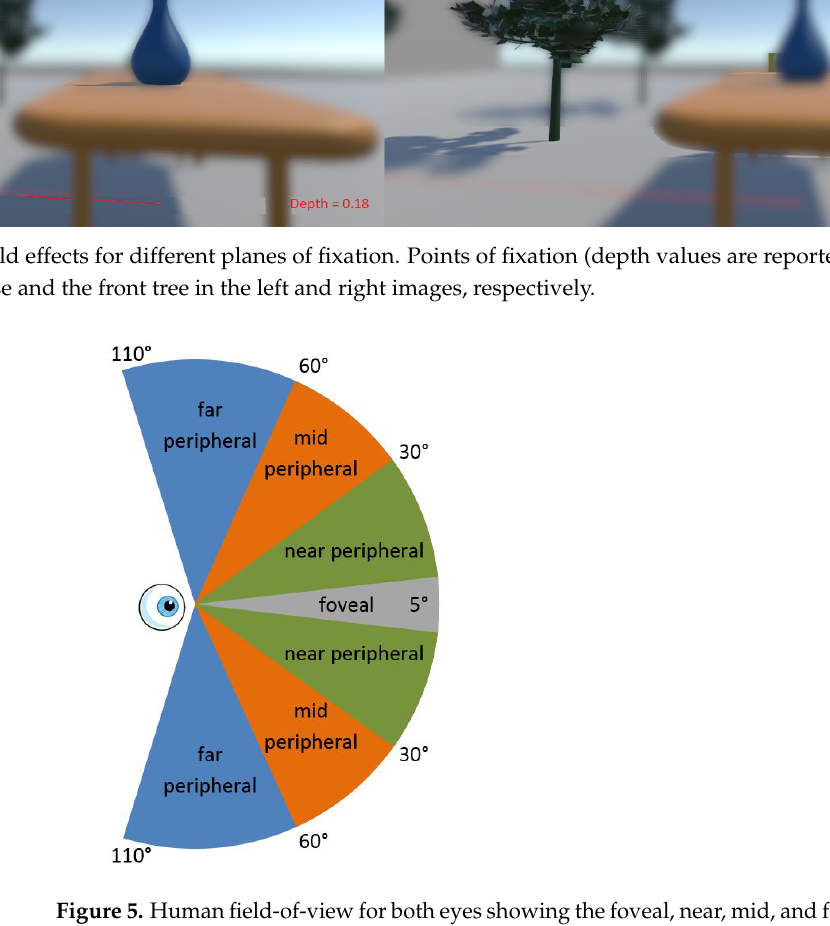
Figure 5. Human field-of-view for both eyes showing the foveal, near, mid, and far peripheral